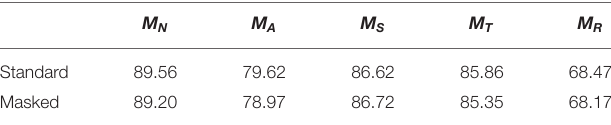
All accuracies are reported on the non-augmented validation